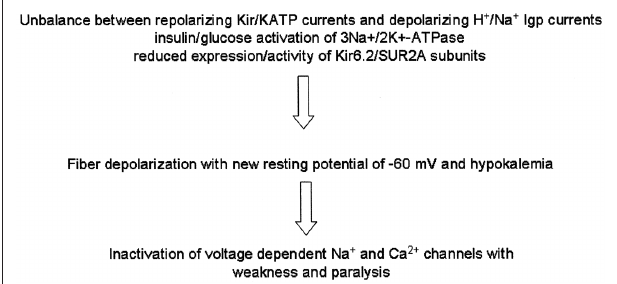
FIGURE 2 | Proposed cascade of the pathogenic events in the hypokalemic periodic paralysis. The unbalance between the depolarizing and repolarizing current components is due to an abnormal activation of depolarizing gating pore currents ( I ) with increased influx of protons or Na + gp ions through mutants and to the abnormal reduction of the repolarizing Kir currents carried by various subtypes of Kir channels. The insulin/glucose administration induces activation of the 3Na + /2K + -ATPase but failed to activate K channels causing a marked hypokalemia. The hypokalemia reduces the ATP gene expression/activity of the Kir6.2 and SUR2A subunits. All these factors contribute to the fiber depolarization setting the resting potentials to a new value of − 60 mV ( V ). The depolarization of the fibers inactivates the m voltage-dependent Na + and Ca 2 + channels with